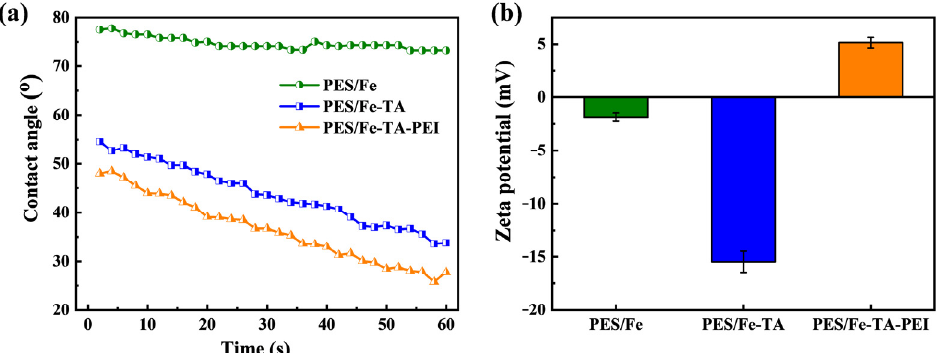
Figure 3. ( a ) WCA and ( b ) Zeta potentials (pH = 6.7) of the PES/Fe, PES/Fe-TA, and PES/Fe-TA-PEI membranes.